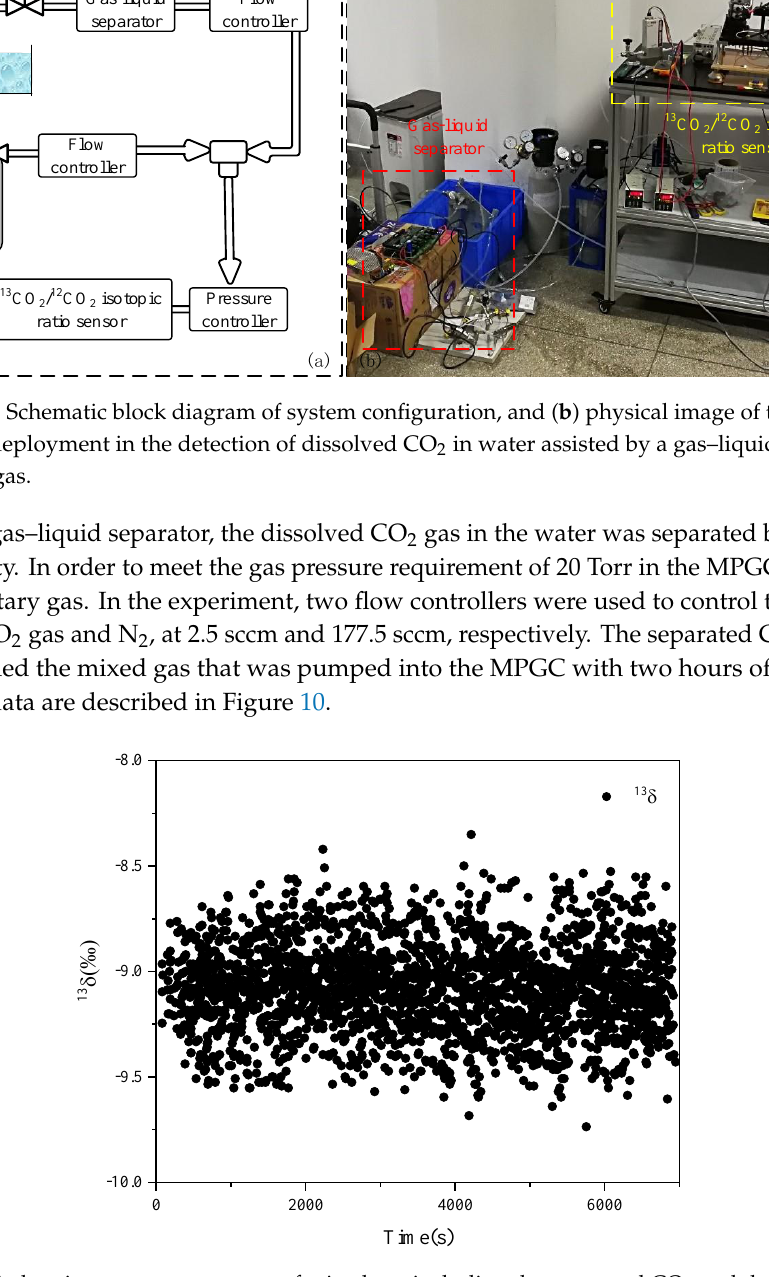
Figure 10. Carbon isotope measurement of mixed gas including the separated CO 2 and the N 2 carrier gas with two hours of measurement.